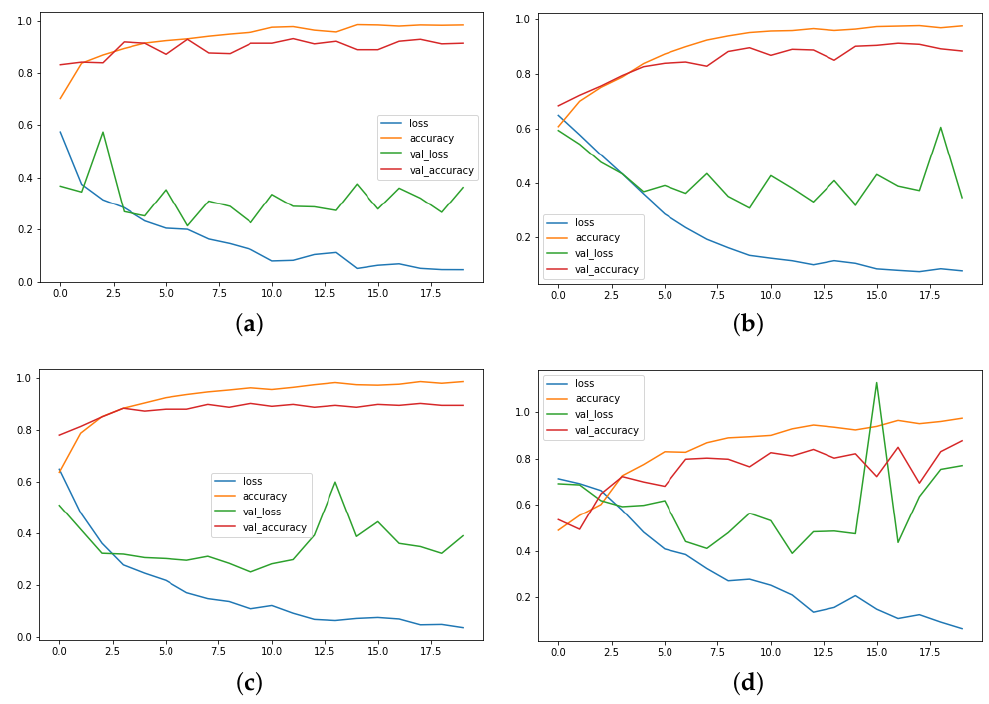
Figure 4. The training and validation graphs of the proposed model for different VD datasets. The x -axis represents the number of epochs, while the y -axis stands for the unit score of loss and accuracy. (Please zoom in for better reading). ( a ) Hockey fight; ( b ) RWF-2000; ( c ) Violent crowd; ( d ) Surveillance